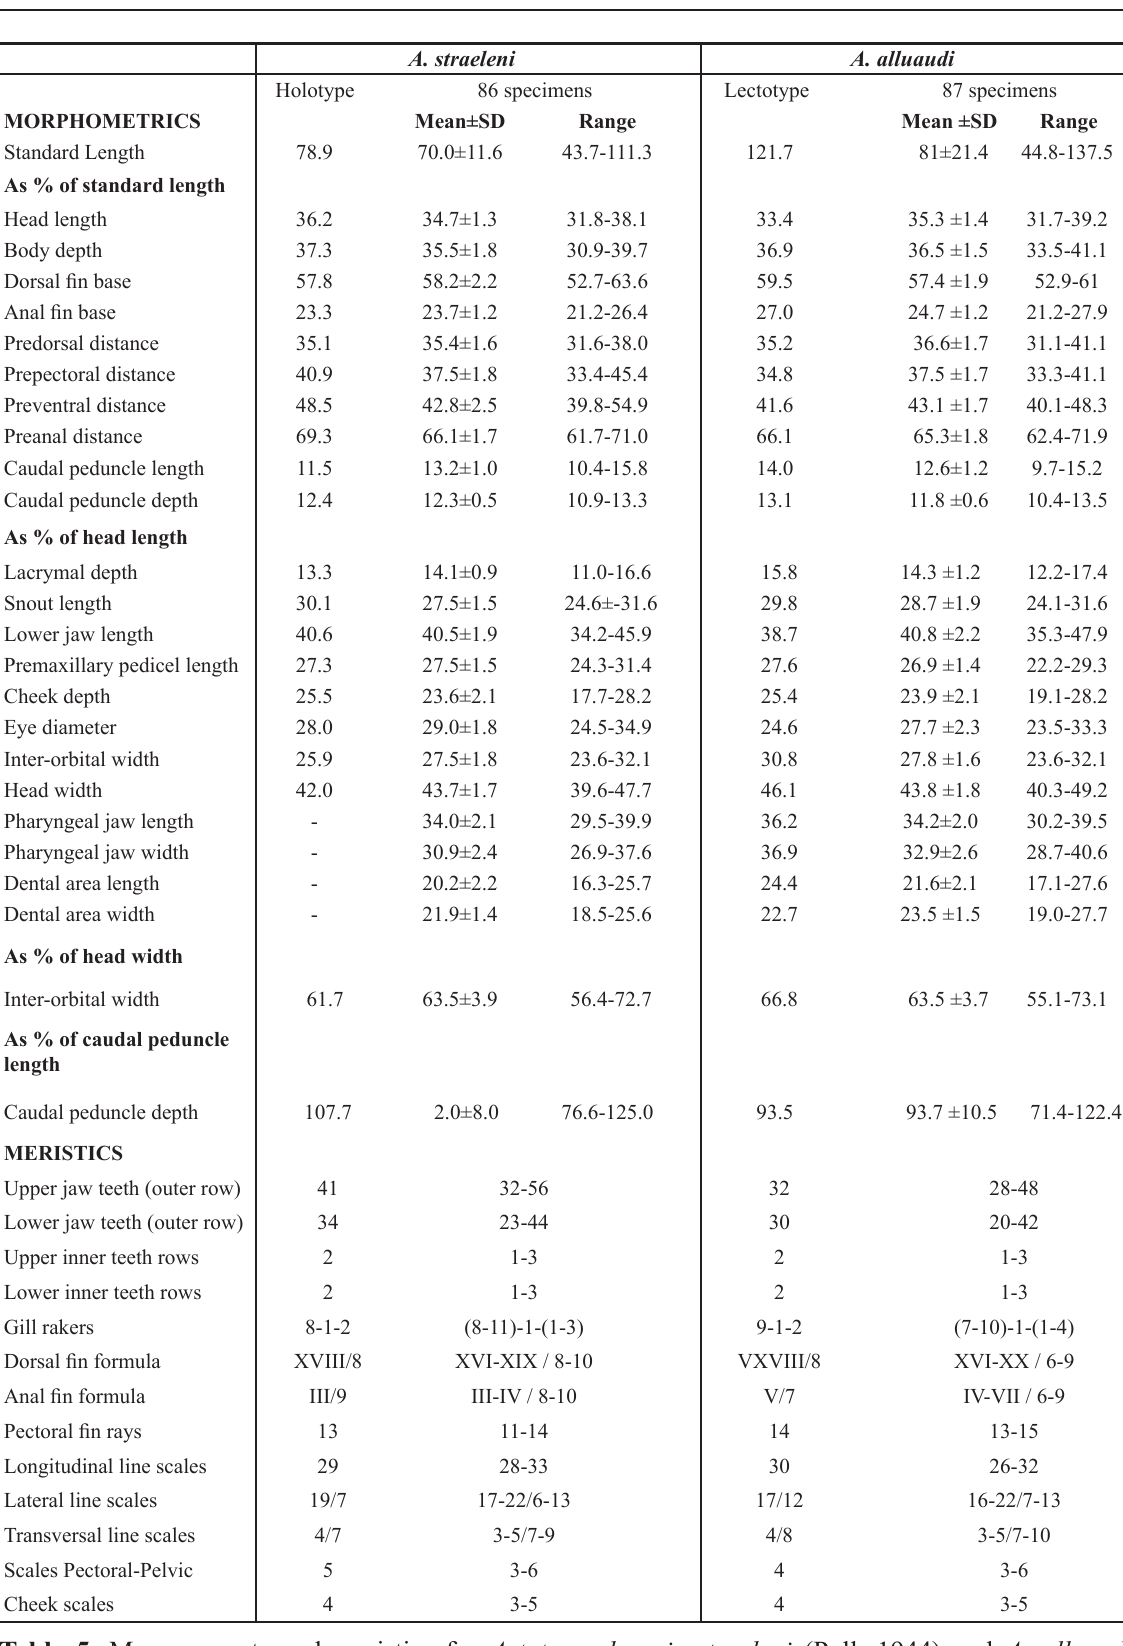
Table 5. Measurements and meristics for Astatoreochromis straeleni (Poll, 1944) and A. alluaudi Pellegrin, 1904